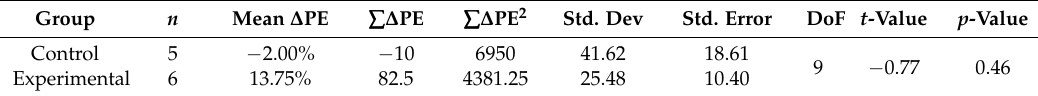
Table 3. Comparison of the statistical significance for both groups’ bodily surface area data.